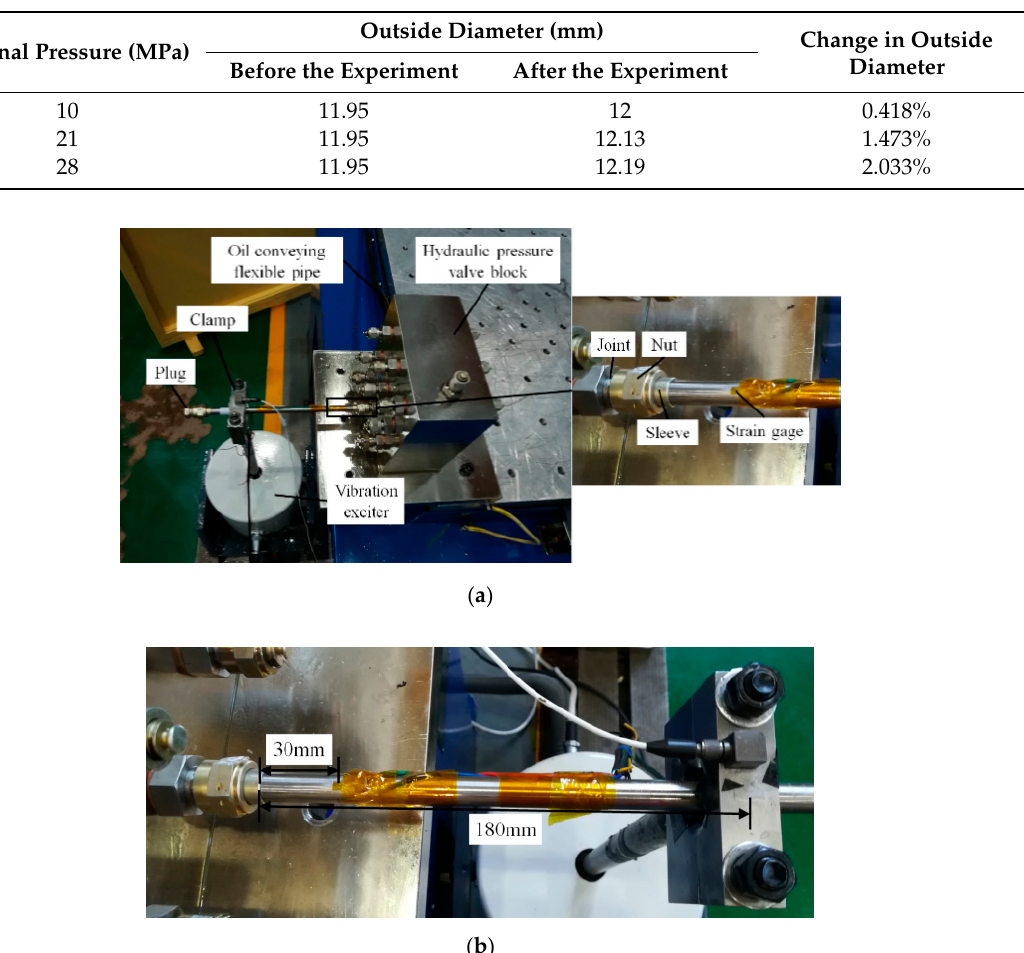
Figure 1. Experimental apparatus: ( a ) Assembly parts and ( b ) key dimensions.